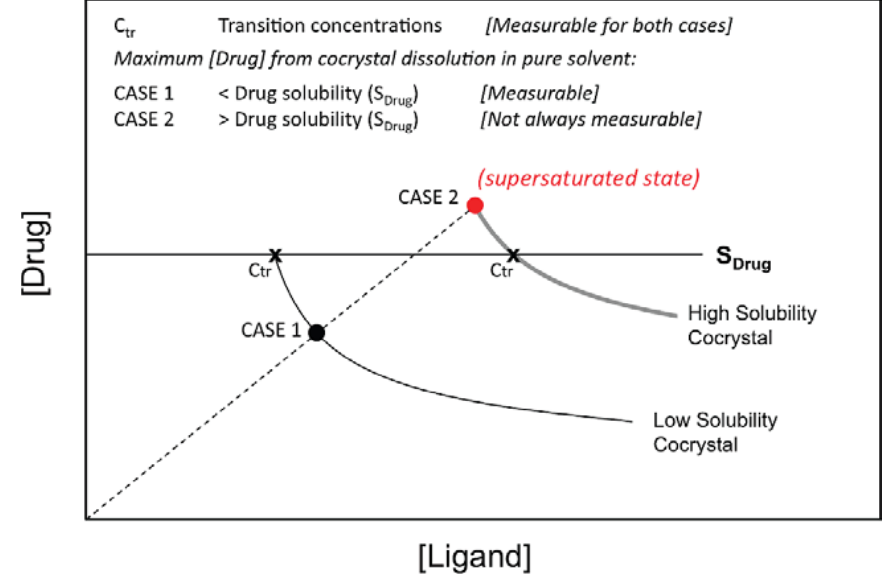
Figure 34. Phase Solubility Diagram explaining the solubility behavior of a low solubility cocrystal (stable cocrystal) and a high solubility cocrystal (metastable cocrystal) based on the K sp value (X—transition concentrations; dashed line—stoichiometric concentrations of cocrystal components; circles—Solubility of cocrystal in pure solvent) [Reprinted from [9] with permission. Copyright 2009 American Chemical Society].